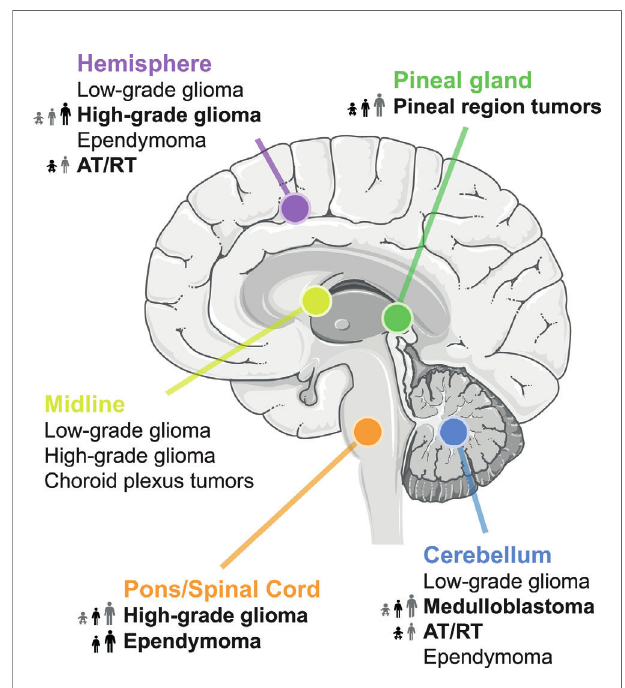
FIGURE 1 | Location of common brain tumors. Tumor entities with known MYC involvement are highlighted in bold and their frequency across all age groups is